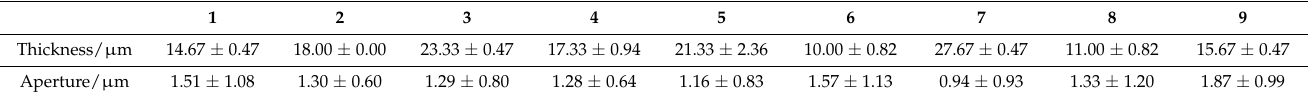
Table 4. Thickness and aperture of fi ber fi lm.